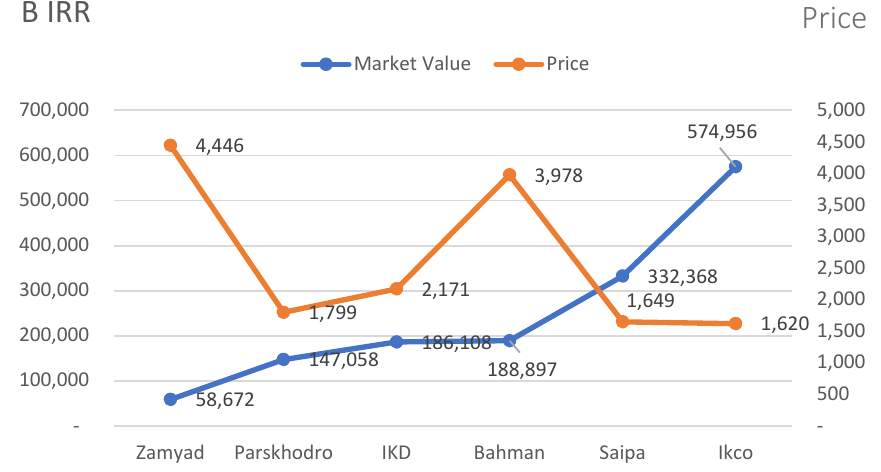
Figure 1. The market value of Iranian automobile companies. Source: Codal website [53].